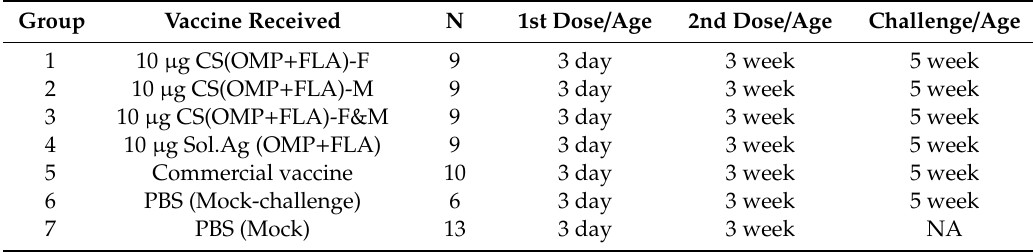
Table 1. Experimental animal